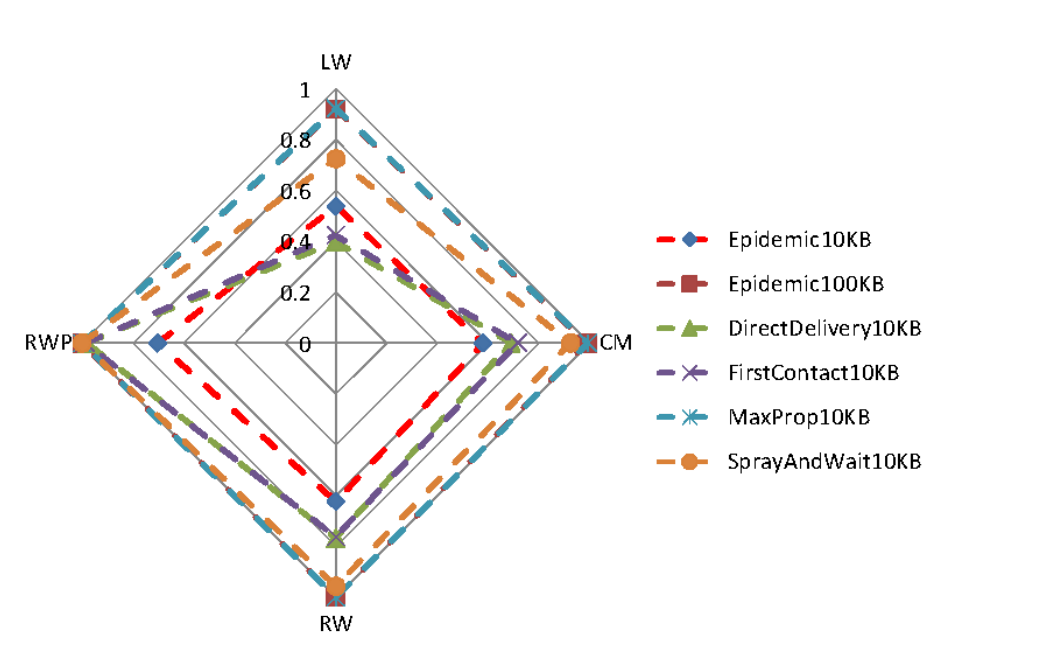
Figure 11. Delivery ratio with different mobility models, 40 nodes.